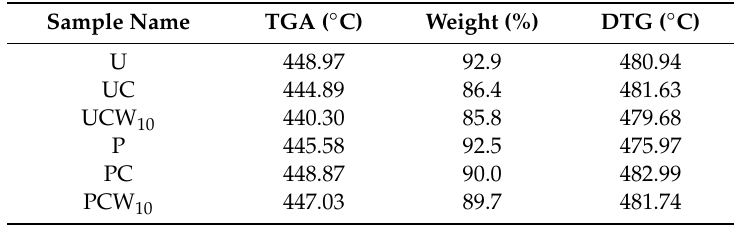
Figure 7. TGA and DTG curves of aramid fabric samples after various treating, coating, and washing processes: ( a , a ’ ) U and P, ( b , b’ ) UC and PC, ( c , c’ ) UCW 10 and PCW 10 , Thermogravimetric Analysis (TGA) and DTG data of aramid samples obtained in N 2